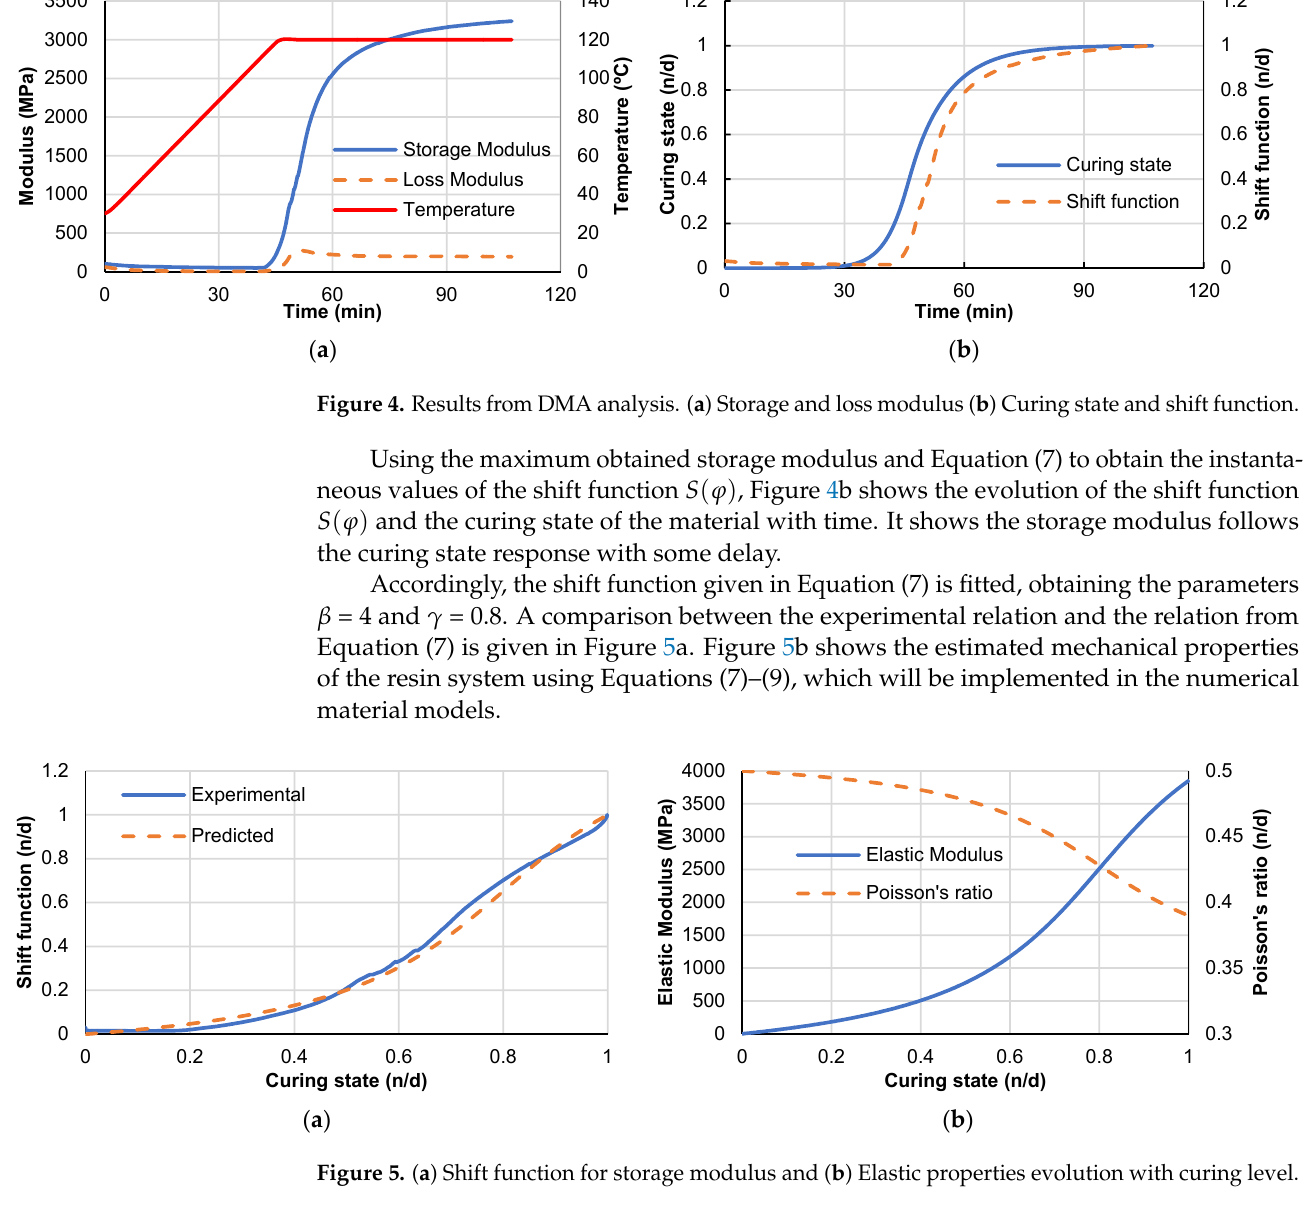
tion 𝑆(cid:4666)𝜑(cid:4667) and the curing state of the material with time. It shows the storage modulus follows the curing state response with some delay.